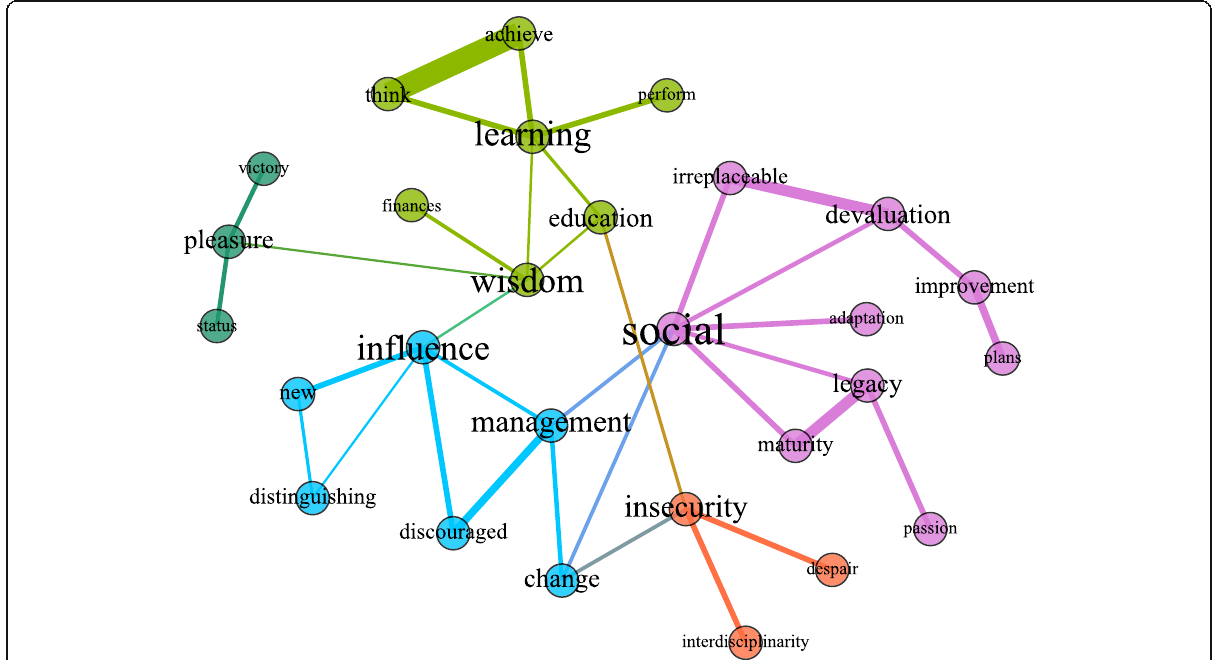
Fig. 4 Semantic network of professional identity for the group of undergraduate students working outside their field. Notes . The colors of the connections between the words represent the communities; the size of the nodes is proportional to their centralities of intermediation, and the thickness of the edges is proportional to the value of the IF